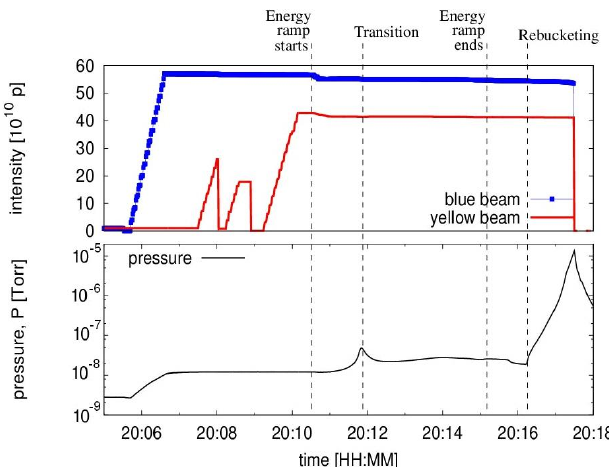
FIG. 5. (Color) A pressure instability with Au beam in the Blue ring. The upper part shows the total intensity for both rings during injection, acceleration, and storage. The lower part shows the pressure in the Blue collimator region, with an exponential increase after rebucketing